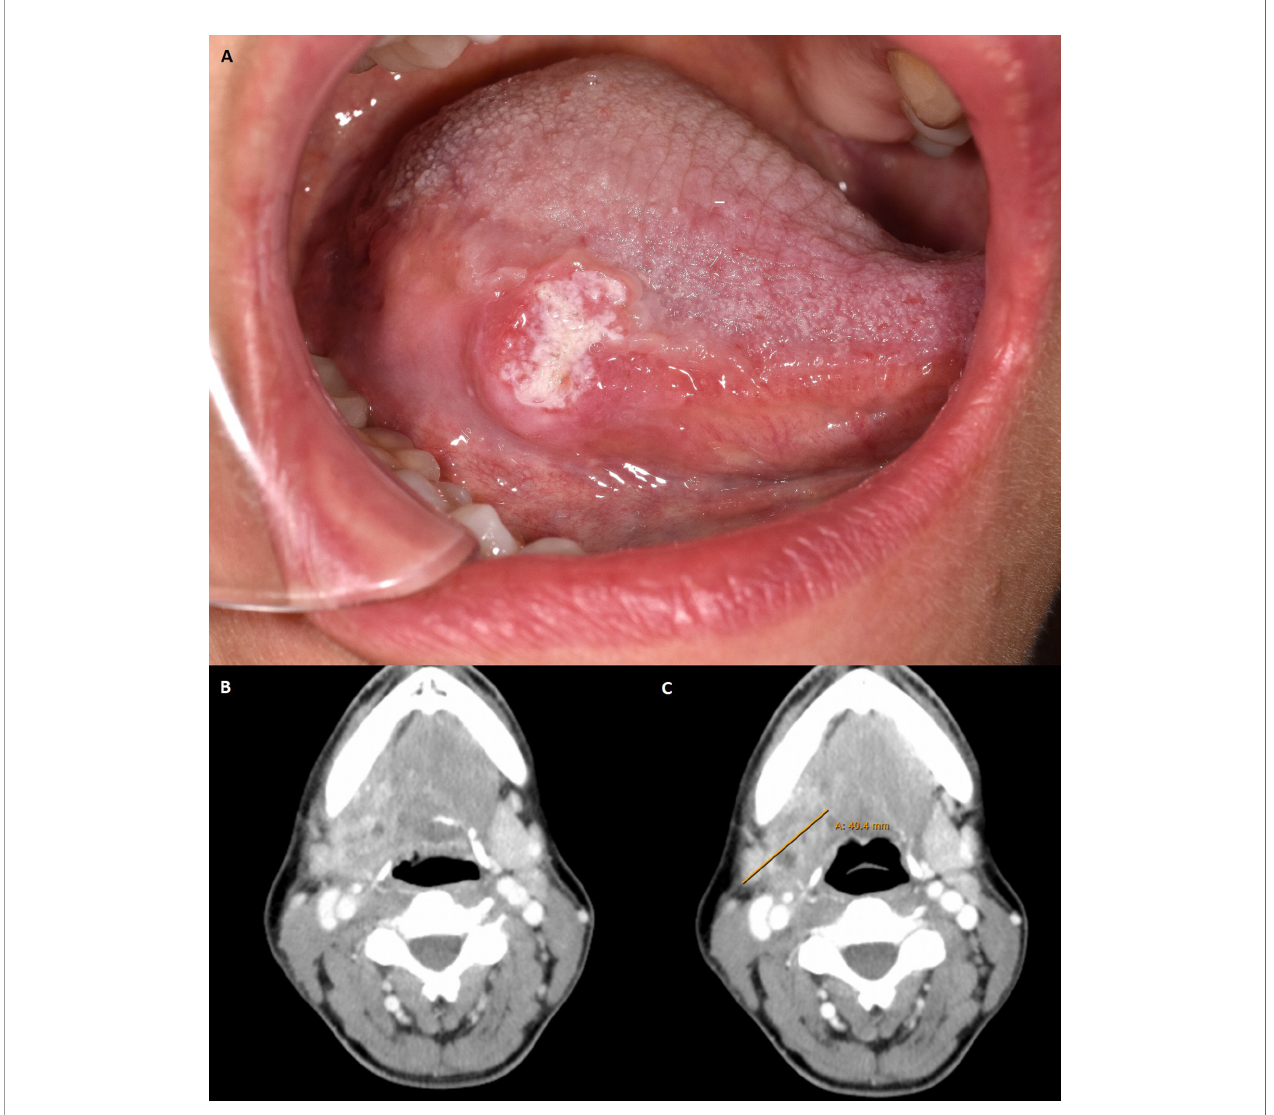
FIGURE 1 | (A) Clinical view of primary tumour at initial presentation. Photo taken at the patient ’ s fi rst presentation. Location of the tumour: right margin of the tongue. (B) Computed tomography with suspicious lesion found in tumour follow-up in late 2019. Axial plane with tumour recurrence in the right mandibular angle. (C) Computer tomography with pathologically con fi rmed tumour recurrence after fi rst use of Pembrolizumab 200 mg. Axial plane with tumour recurrence in the right mandibular angle. Max. diameter 40,4 mm. Radiological assessment: Metastasis submandibular increasingly